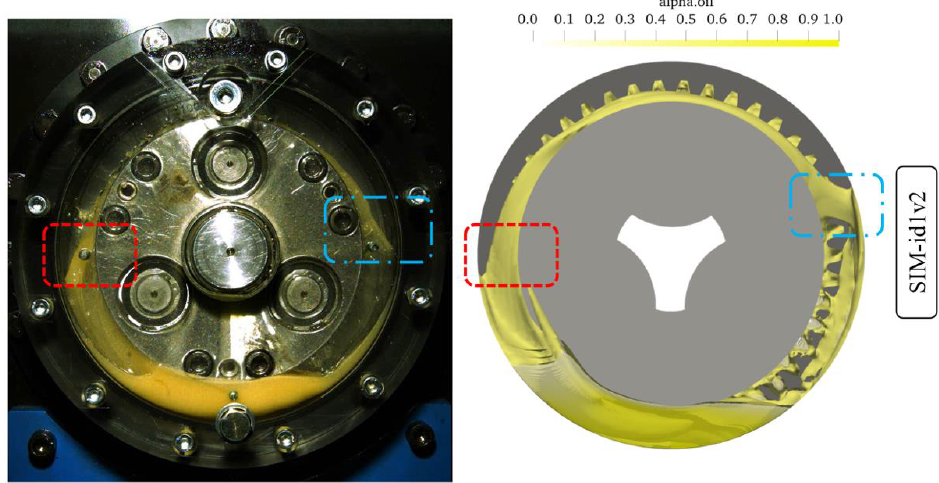
Figure 7. Experimental ( left ) and CFD ( right ) comparison of the oil flow for SIM-id1v2.